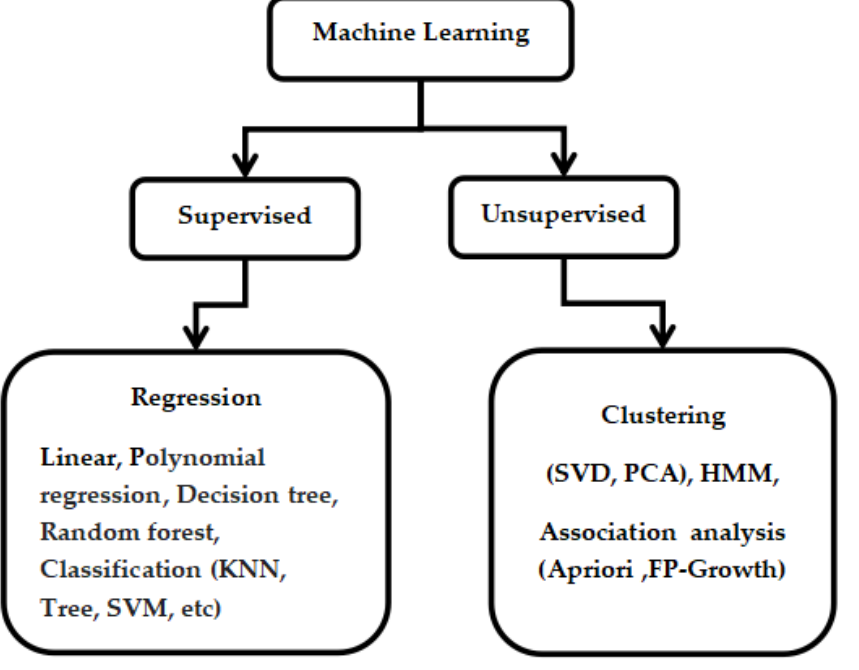
Figure 8. Machine learning algorithms [80].